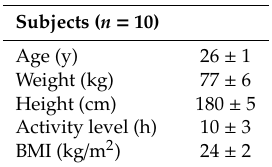
Table 1. Subject